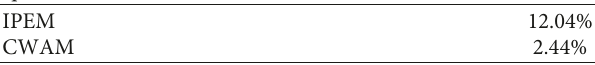
Figure 5: Comparison of the seventh point’s random excitation identification results. Table 5: The seventh point’s excitation relative errors of root mean square value.